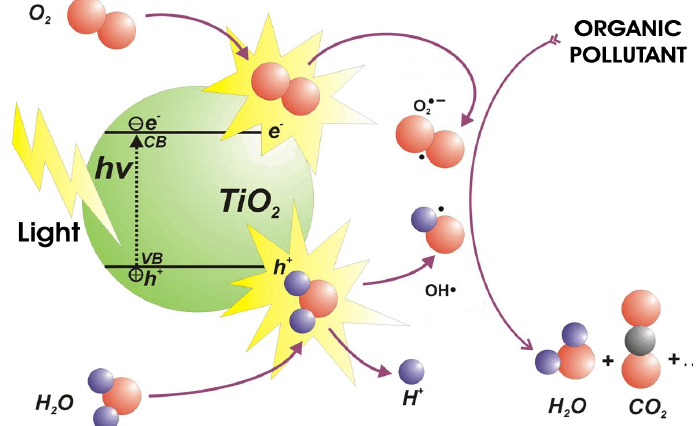
Figure 1. Schematic of semiconductor excitation by band gap illumination [4,7] leading to the creation of “electrons” in the conduction band and “holes” in the valance